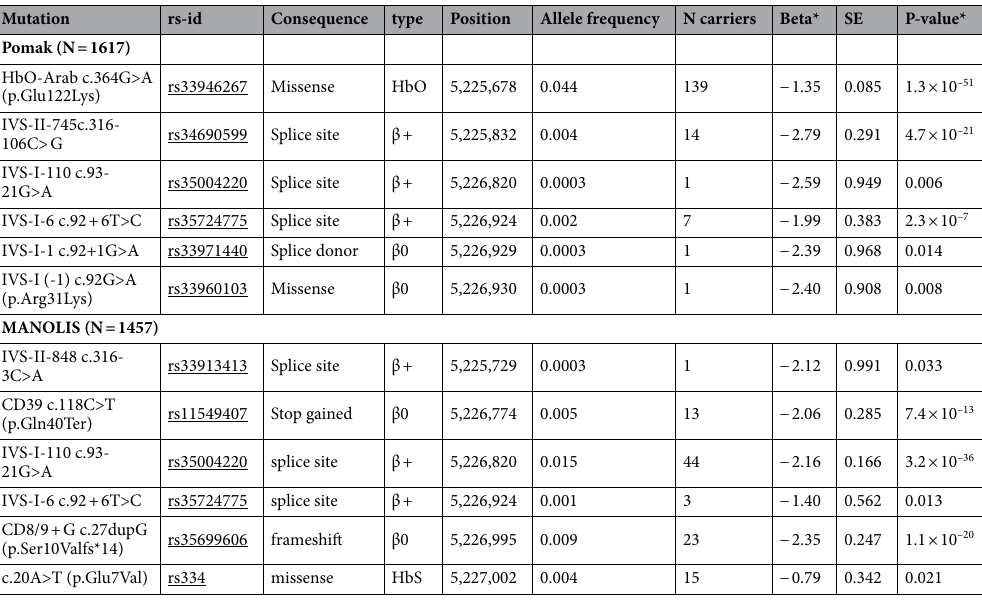
Table 2. Pathogenic HBB mutations in Pomak and MANOLIS and their associations with red cell distribution width. * Regression coefficient beta and p value for the association of the variant with red cell distribution width in units of standard